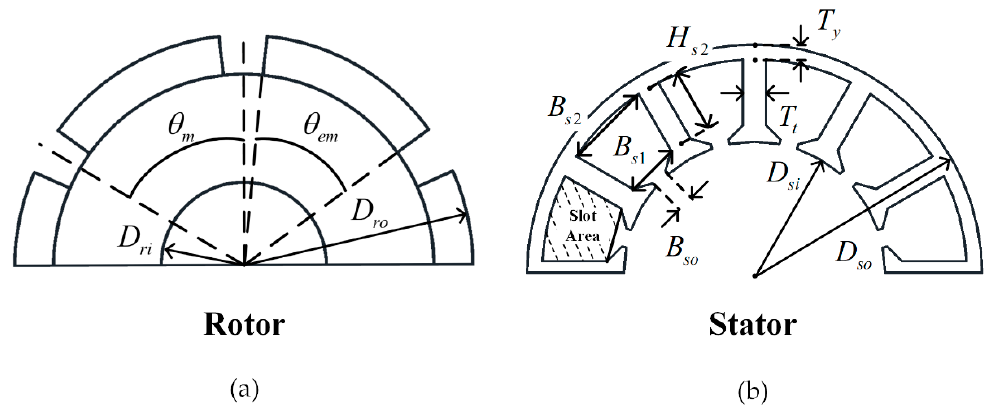
Figure 4. Conceptual diagram of motor: ( a ) Rotor; ( b ) Stator.